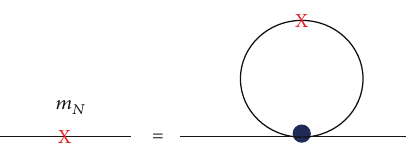
Figure 4: The gap equation for the Nambu-Jona-Lasinio model for generating nucleon